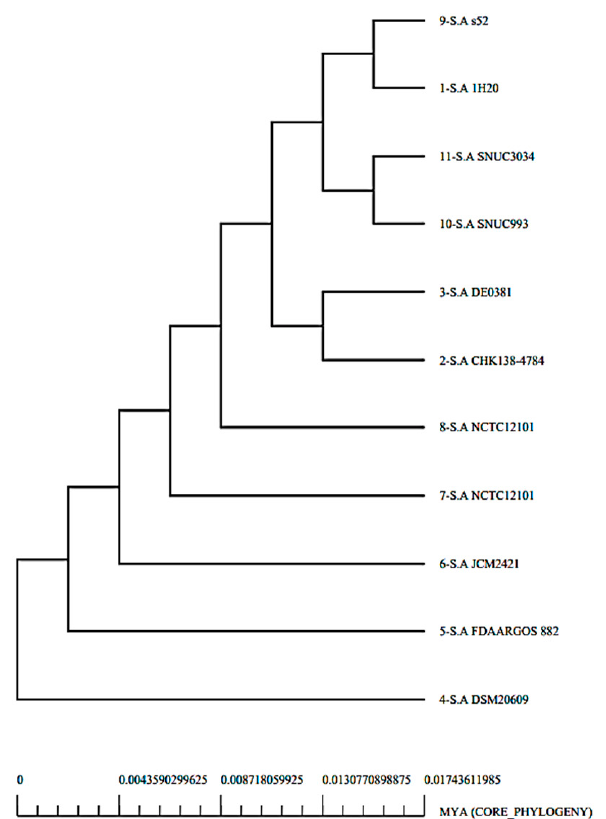
Figure 3. A pan ‐ phylogenetic tree of the genome of S. auricularis .